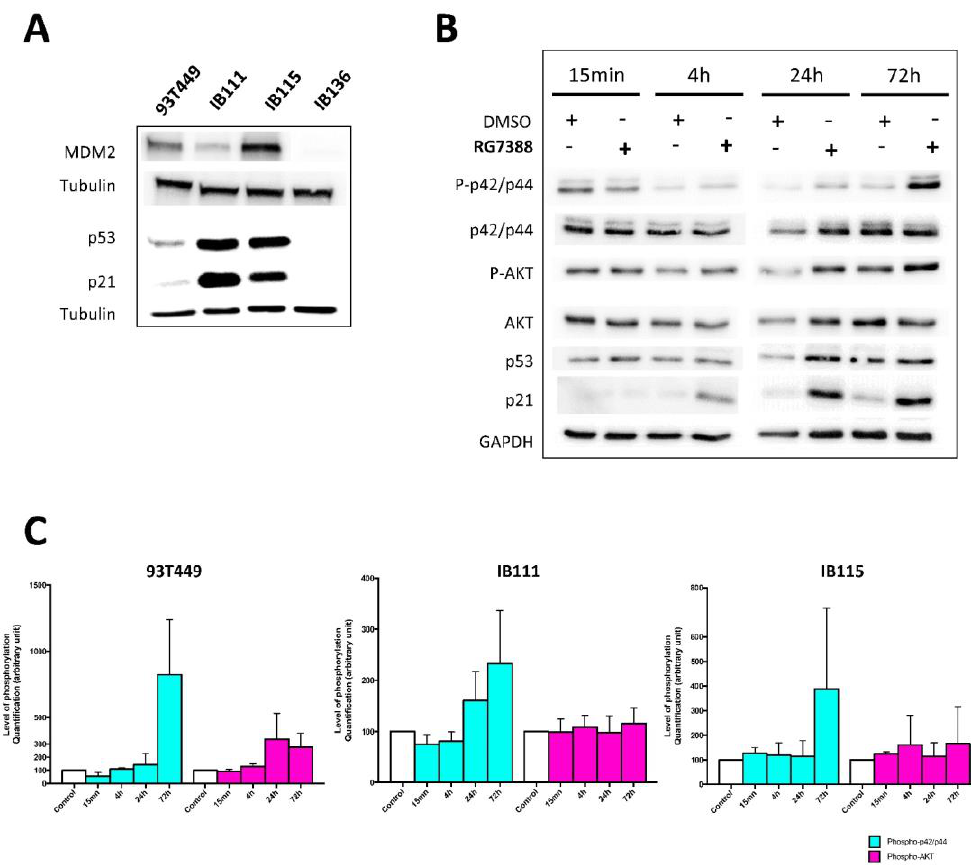
Figure 3. E ff ects of RG7388 as a single agent on activation of the downstream signaling pathways. ( A ) Western blot analysis showing the level of expression for the indicated proteins in 93T449, IB111, IB115 and IB136 cells. ( B ) Western blot analysis showing the level of phosphorylated and total protein for the indicated proteins in 93T449 cells treated for 15 min, 4 h, 24 h and 72 h with RG7388 at the IC50 concentration (0.04 µ M). ( C ) Quantification of the western blot analyses shown in ( B ) and in the two other cell lines (IB111 and IB115) performed on cells treated with RG7388 for 15 min, 4 h, 24 h, and 72